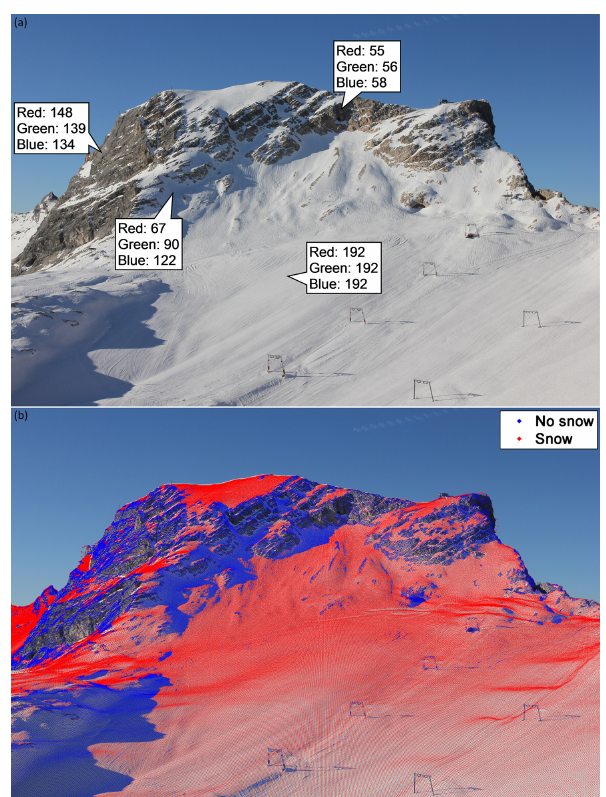
Figure 3. SLR photograph of Schneefernerkopf with large shadows on 17 November 2011: (a) the outlined RGB values (8bit data, from 0 to 255) for the different surfaces show similarly high blue band values for shaded snow cover and illuminated rock areas. (b) Hence, shaded snow cover is erroneously classified as free of snow in the algorithm of Salvatori et al.